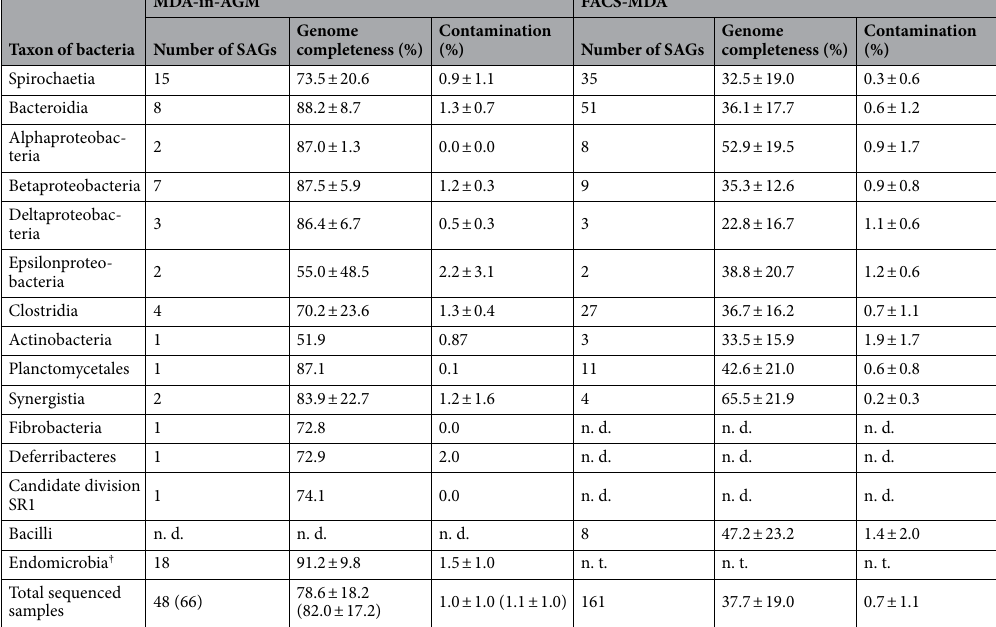
Table 1. Summary of single-cell amplified genomes (SAGs) of symbiotic bacteria in termite gut bacteria. The numbers of SAGs, genome completeness and contaminants including Endomicrobia are shown in parentheses. n. d. not detected, n. t. not tested. † NGS libraries were made by Nextera XT and read by